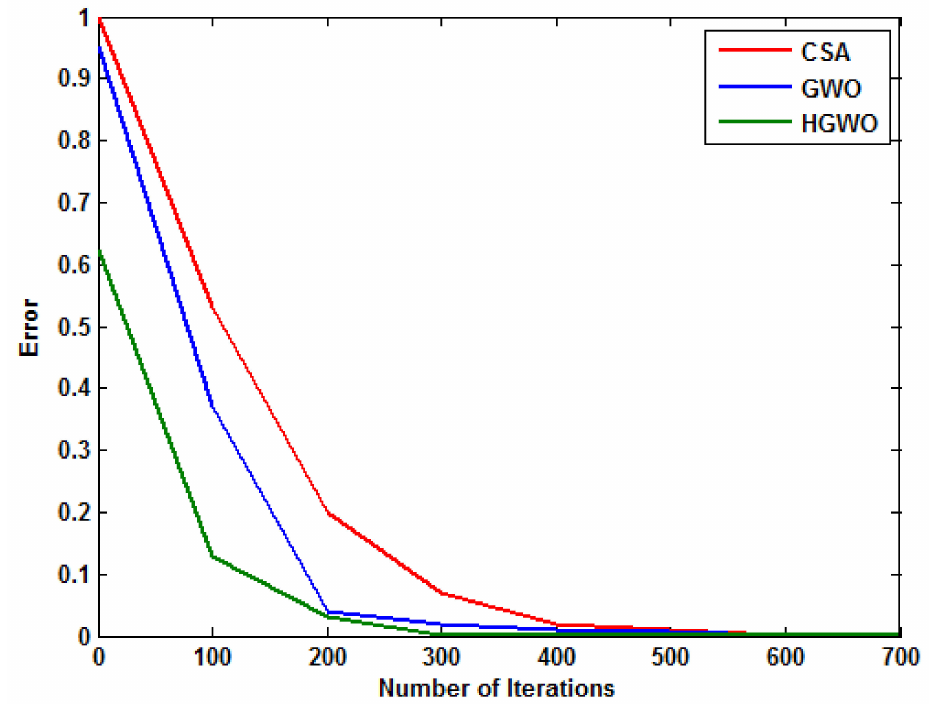
Figure 10. Error convergence of the proposed